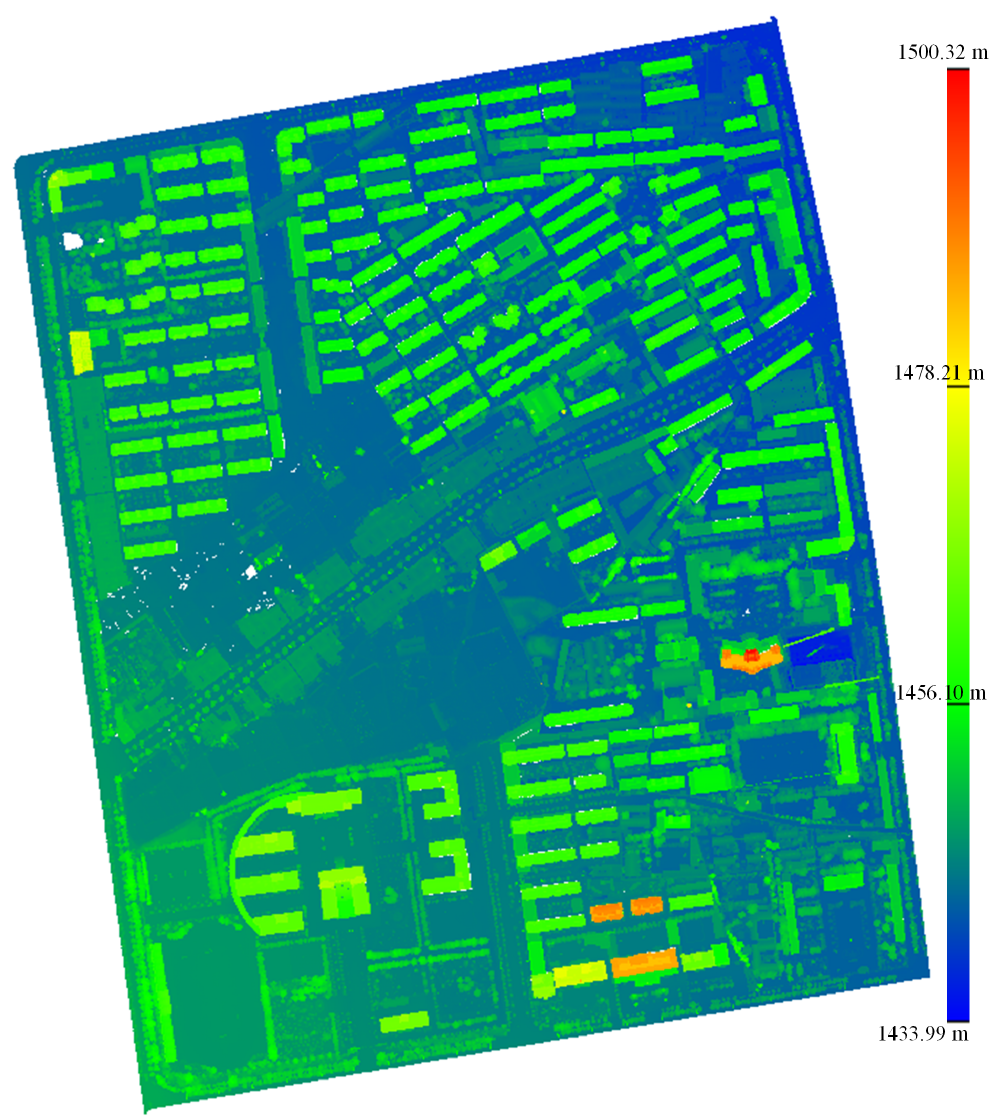
Figure 2. The height map of the annotated